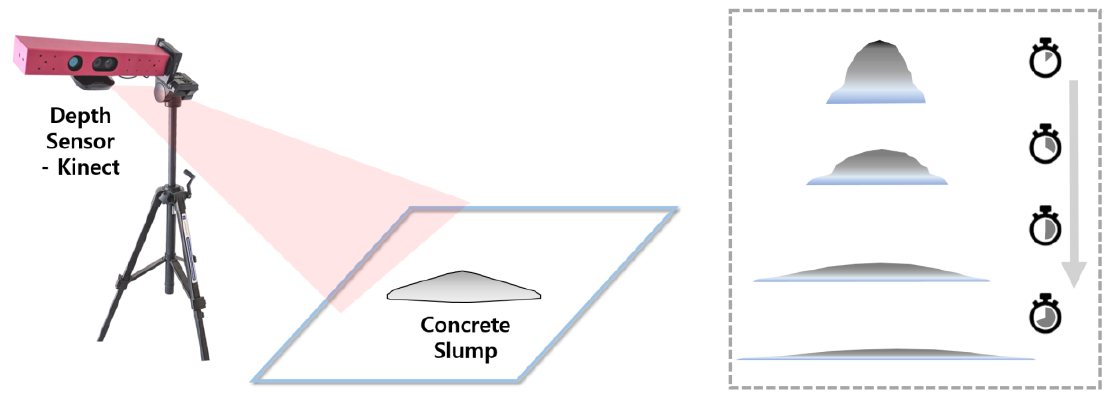
Figure 2. Utilization of the depth sensor during the slump flow test; recording and processing of a dynamically changing surface of fresh concrete.